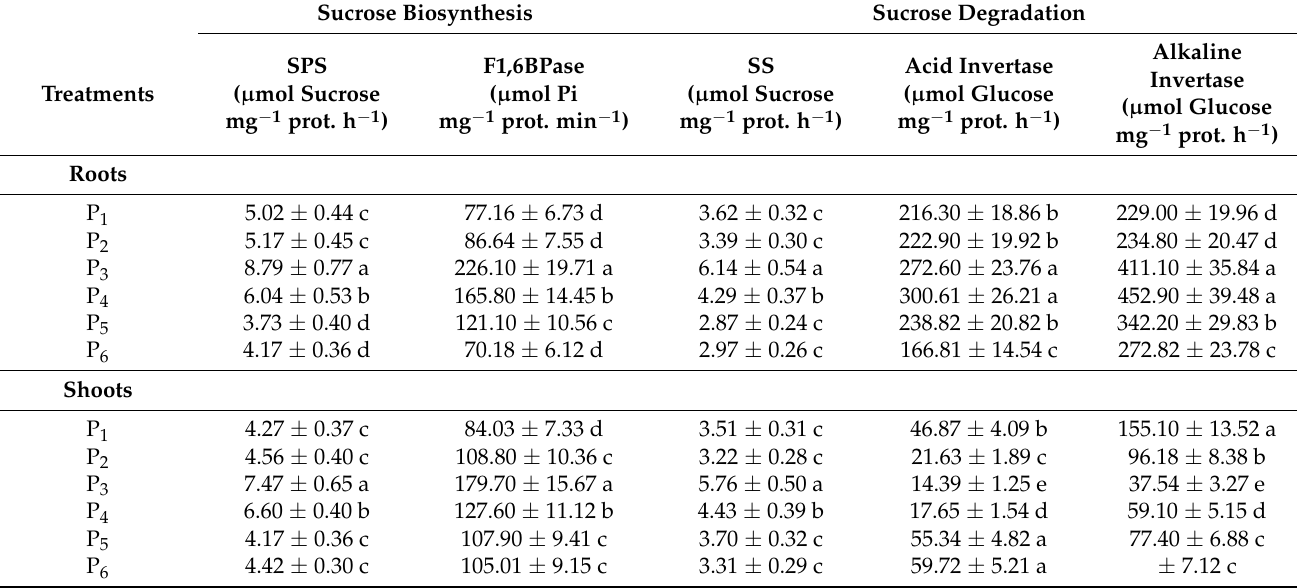
Table 2. Effects of different P treatments on the key enzymes involved in the biosynthesis and degradation of sucrose in roots and shoots of green bean plants at the end of the experiment. n = 6. Means ± standard deviation within columns with different lower-case letters are significantly different at p < 0.05 (one-way ANOVA and LSD